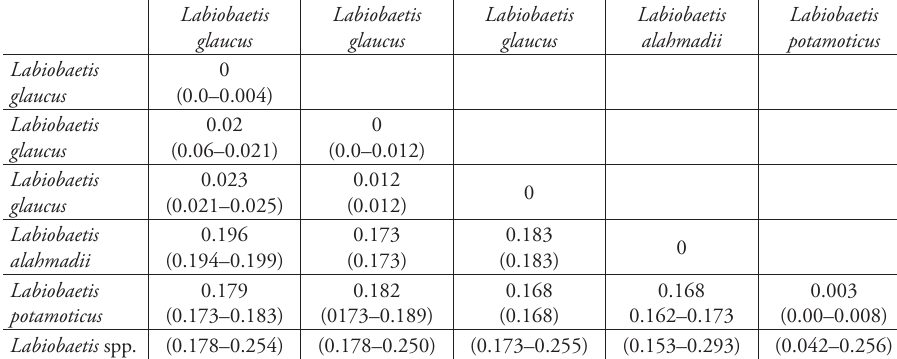
Table 2. Estimates of evolutionary divergence between major haplogroups of Labiobaetis species (using corrected p distances). In brackets are indicated the minimum and maximum